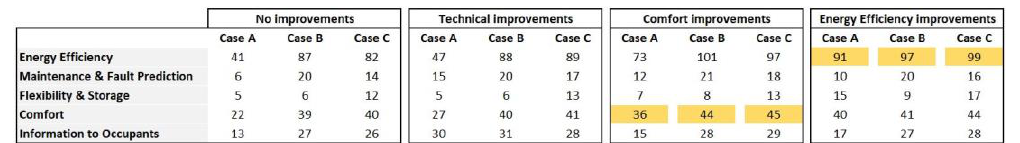
Figure 14. Comparison of the total points collected by each building in the different scenarios against all the five impact criteria considered.